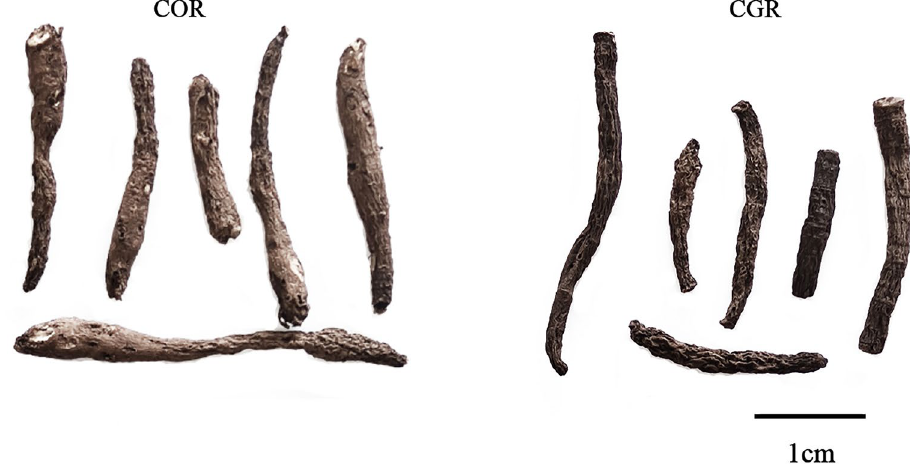
Figure 1. Curculigo orchioides Rhizoma (COR) (left) and Curculigo glabrescens Rhizoma (CGR)